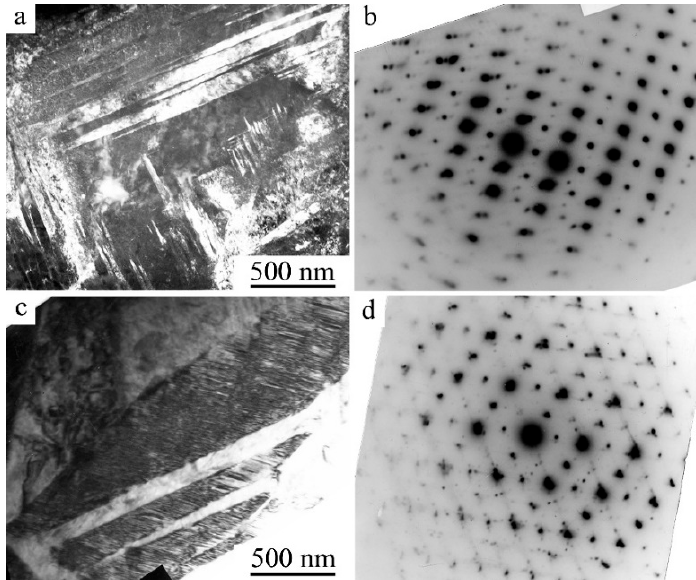
Figure 7. TEM images of the microstructure of B19 ′ martensite and the corresponding SAED ( a , b ) of alloys Ti 50 Ni 45 Cu 5 at 250 K and ( c , d ) Ti 50 Ni 40 Cu 10 at 120 K.